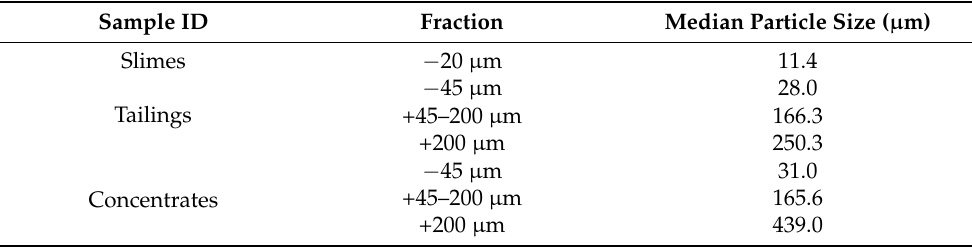
Table 2. Mean Particle size in flotation products.